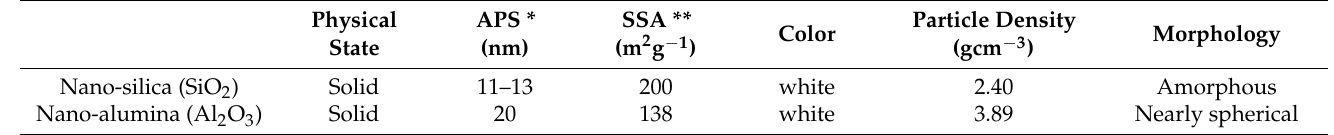
Table 2. Physical properties of nano-silica and